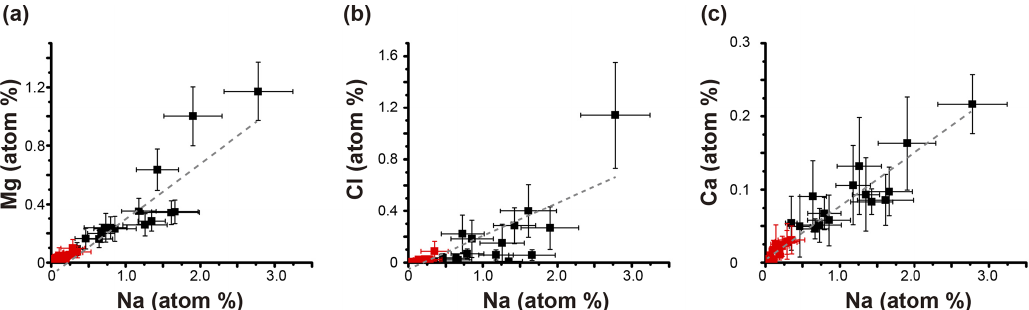
Figure 9. Relations of Na with Mg, Cl, and Ca among all particles. The plots show the average atomic percent values of all particles within each sample. The black and red plots are the samples < 1000 and > 1000m, respectively. R 2 values are 0.84, 0.61, and 0.89 for panels (a) , (b) , and (c) , respectively. Approximated curves are shown with the gray dashed lines. The error bars indicate the 95% confidence intervals.